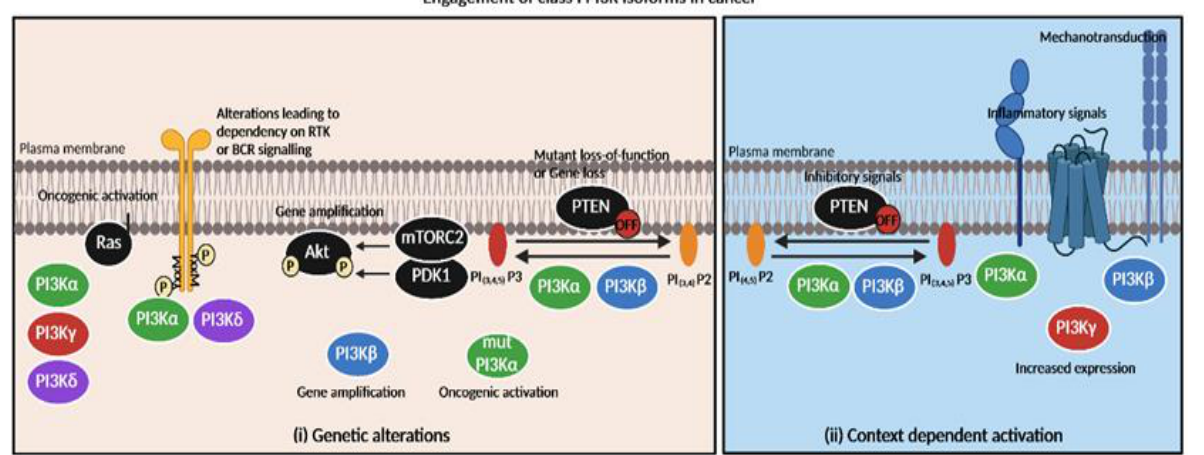
Figure 2. Engagement of class I PI3K isoforms in cancer depending on genetic alterations or context- dependent activation. Tumors’ specific dependency on PI3K inhibitors is mainly based on ( i ) genetic alterations and ( ii ) context-dependent activation of isoforms. ( i ) Oncogenic activation of PI3K α catalytic domain leads to PI3K α sensitivity while PI3K β gene amplification or PTEN loss is responsible for PI3K β inhibitors’ efficacy. RAS oncogenic activation directly couples with PI3K α , γ or δ isoforms (but not PI3K β ) [49,50]. ( ii ) GSK3 β -dependent inhibitory phosphorylation of PTEN could possibly increase sensitivity to PI3K α or PI3K β inhibitors. Inflammatory context (e.g., TNF α [17], GPCR ligand S1P [43]) activates PI3K α or PI3K β /PI3K γ , respectively. Mechanical signals possibly promote PI3K β activation [40]. Increased expression of PI3K γ promotes PI3K activation